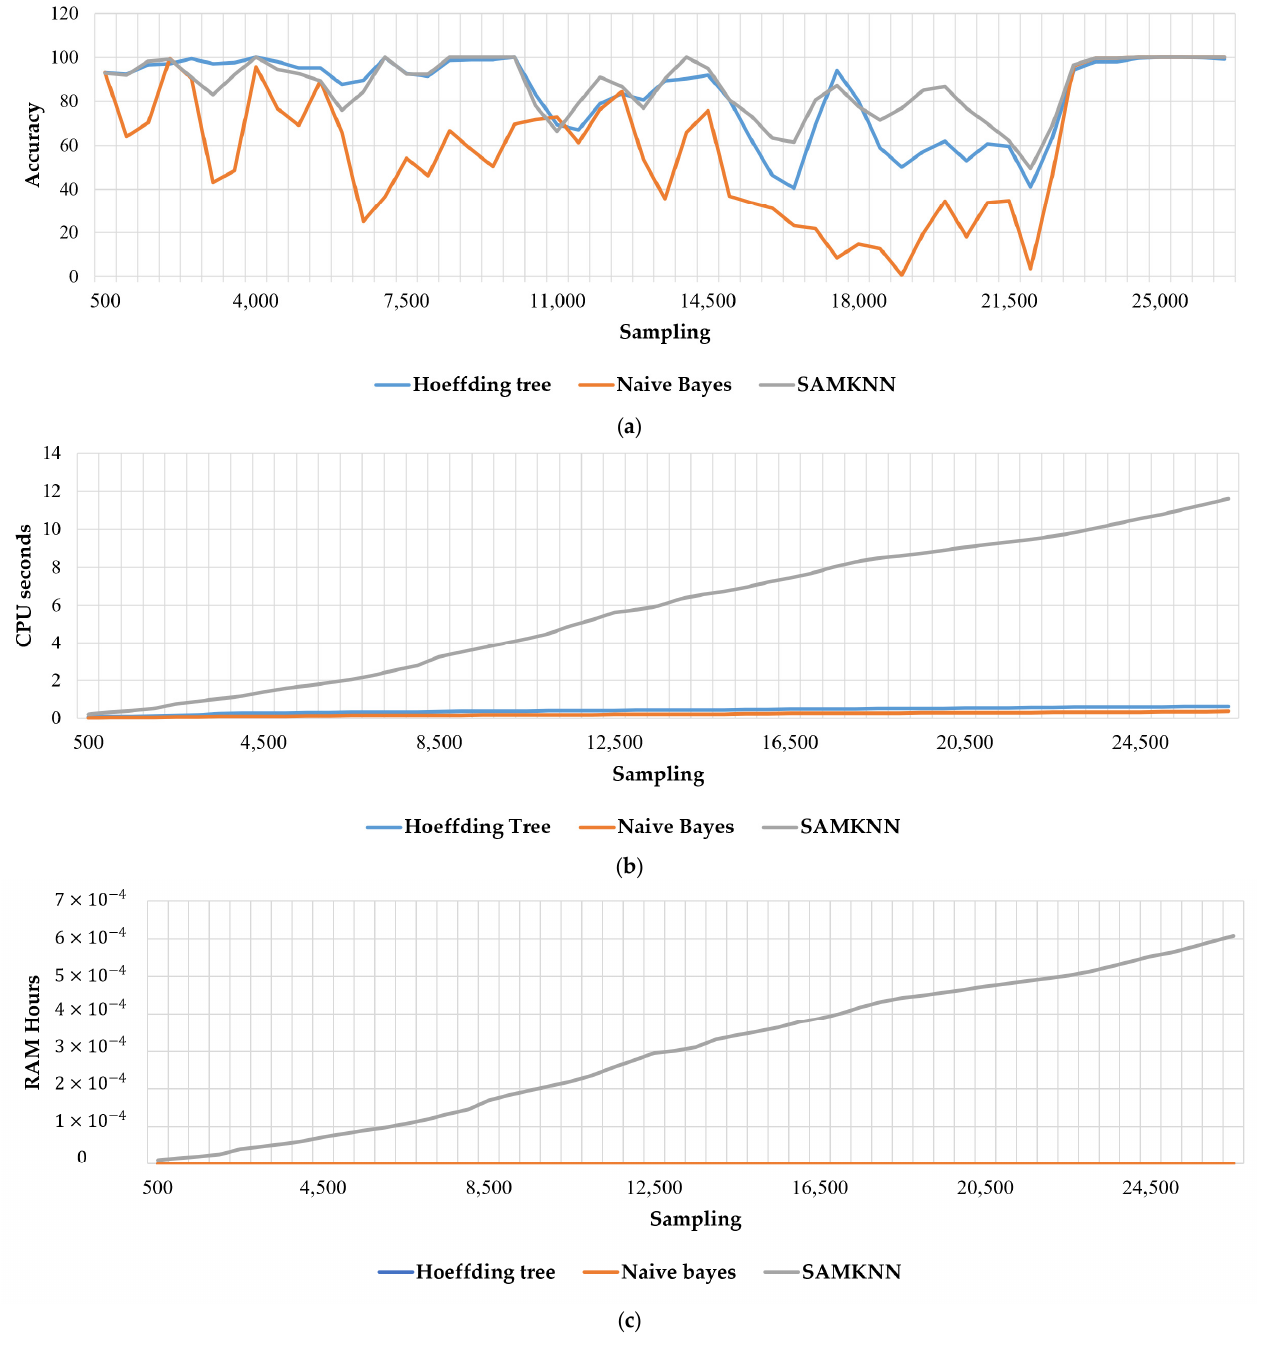
Figure 8. Evaluation results of the presented algorithms: ( a ) accuracy, ( b ) CPU seconds, ( c ) RAM hours.